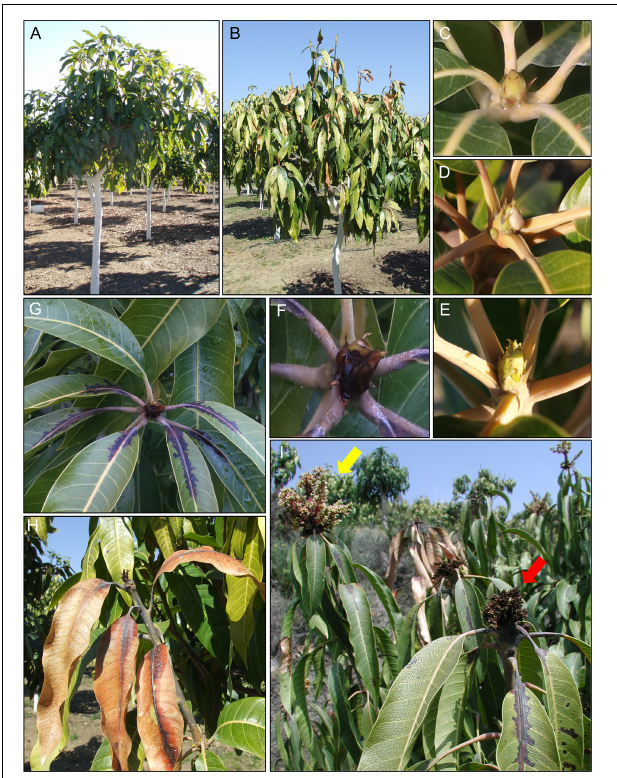
FIGURE 1 | Typical symptoms of bacterial apical necrosis (BAN) disease on mango trees. (A) Healthy mango tree. (B) Mango tree affected by BAN disease. (C) Healthy mango apical bud. (D) Typical gum exudes on mango apical bud. (E) Initial necrotic spots on mango apical bud. (F) Severe necrosis of mango apical bud. (G) Necrotic symptoms progression from apical bud to leaves through the petiole. (H) Dead mango apical bud and surrounded leaves. (I) Flower panicles. Yellow arrow: healthy mango flower panicle; red arrow: necrosis on mango flower